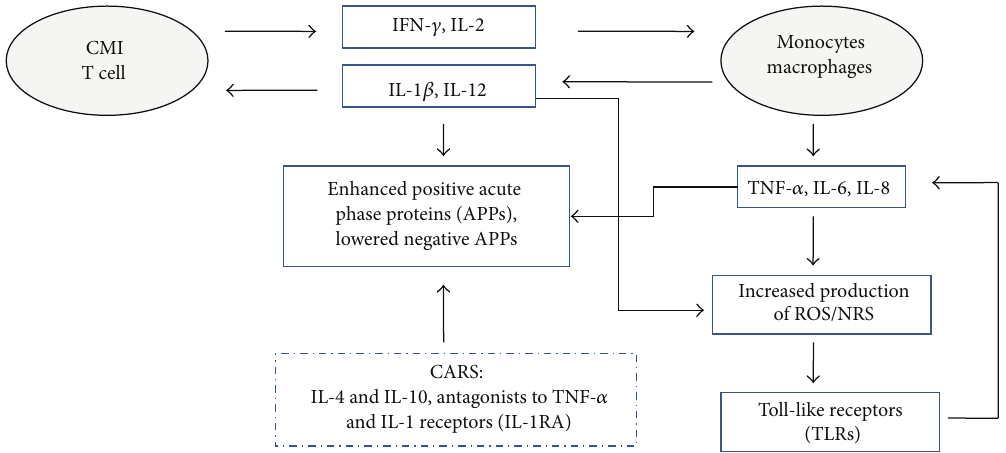
Figure 1: Relationship between activated immune-inflammatory pathways and oxidative/nitrosative stress (O&NS). CMI involves activation ofTcellsthatproducecytokinessuchasIFN- 𝛾 andIL-2,whichactivatemonocytes/macrophages.Monocytes/macrophagesproduceIL-1 𝛽 and IL-12 (that exert a positive feedback loop on T cells), as well as TNF- 𝛼 , IL-6, and IL-8. Proinflammatory macrophage-derived cytokines (PICs) mediate inflammation enhancing the positive acute phase proteins (APPs), for example, C-reactive protein, and lowering the negative APPs, for example, albumin. The counterinflammatory response syndrome (CARS) tends to dampen the acute inflammatory response producing IL-4 and IL-10 (responsible for decreasing TNF- 𝛼 , IL-1, IL-6, and IL-8) and the antagonists to TNF- 𝛼 and IL-1 receptors (IL-1RA), which inactivate the cytokine or block the receptors. Immune inflammation and O&NS influence each other. Inflammatory and CMI responses are accompanied by increased production of reactive oxygen species (ROS) and reactive nitrogen species (RNS) while oxidative stress maintains inflammation mainly through the activation of toll-like receptors (TLRs). Damaged macromolecules released during condition of oxidative stress can activate TLRs which produce an inflammatory response whose key mediators are IL-1, IL6, and TNF- 𝛼 . CMI: cell-mediated immune; IL-6: interleukin-6; IL-1 𝛽 : interleukin-1 𝛽 ; IL-12: interleukin-12; TNF- 𝛼 : tumor necrosis factor- 𝛼 ; IFN- 𝛾 : interferon- 𝛾 ; APPs: acute phase proteins; TLRs: toll-like